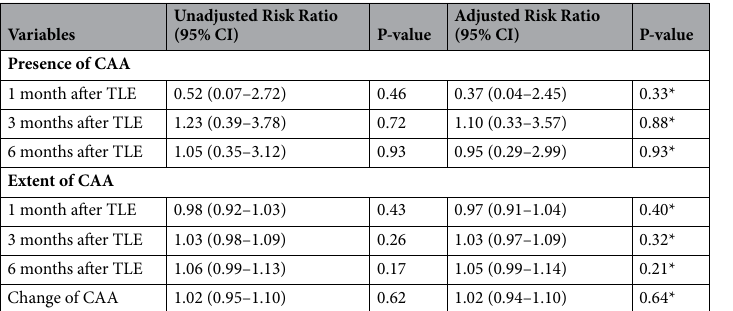
had too much noise. It is known that averaging multiple images helps improve the image quality of posterior segment OCTA 35 . In the future, averaging AS-OCTA images may help to improve image quality.